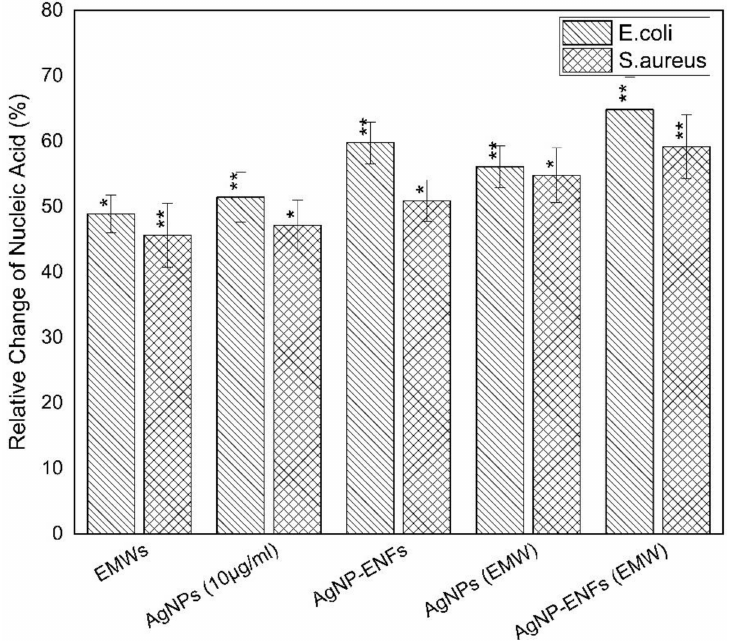
Figure 13. Relative percentage of nucleic acid extortion outside the cell for E. coli and S. aureus samples treated by Ag NPs, Ag NPs-ENFs and EMWs; * statistically significant, ** statistically highly